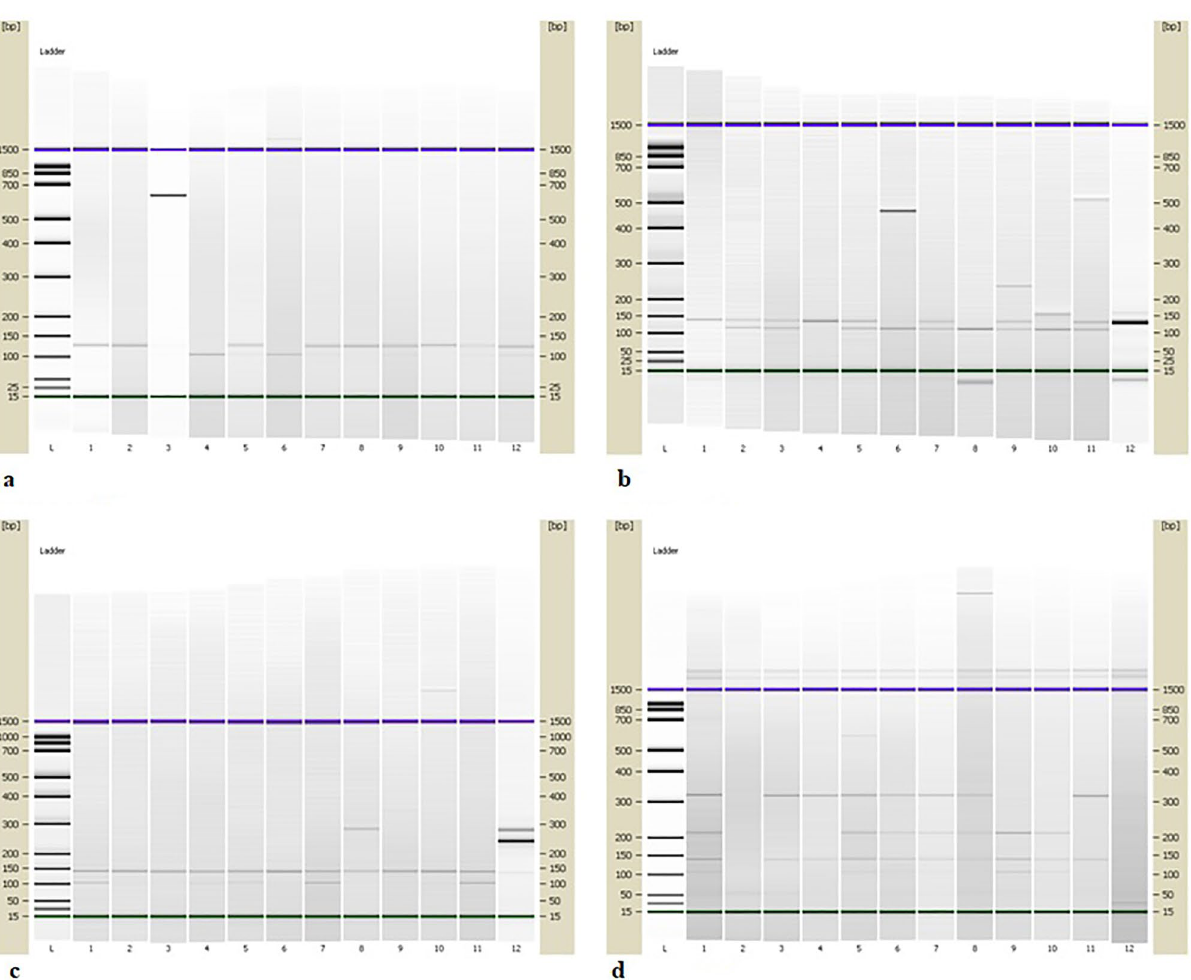
Figure 2. Detection of polymorphisms by PCR–RFLP method. ( a ) TGFB1 C-509TC: column L- DNA Ladder ; column 1, 2, 8, 10- CC genotype; column 5, 7, 9, 11, 12- CT genotype; columns 4, 6- TT genotype. ( b) TGFB1 Leu10Pro: column L- DNA Ladder ; columns 1, 4- ProPro genotype; column 2, 3, 5, 7, 9, 11- LeuPro genotype; columns 6, 8, 10- LeuLeu genotype, column 12- PCR product. ( c) XRCC1 Arg280His: column L- DNA Ladder ; columns 1, 2, 3, 4, 5, 6, 7, 9, 10, 11- ArgArg genotype; column 8- ArgHis genotype; column 12- PCR product. ( d) XRCC3 Thr241Met: column L- DNA Ladder ; columns 1, 5, 6, 7, 8- ThrMet genotype; columns 3, 4, 11- ThrThr genotype; columns 9, 10- MetMet